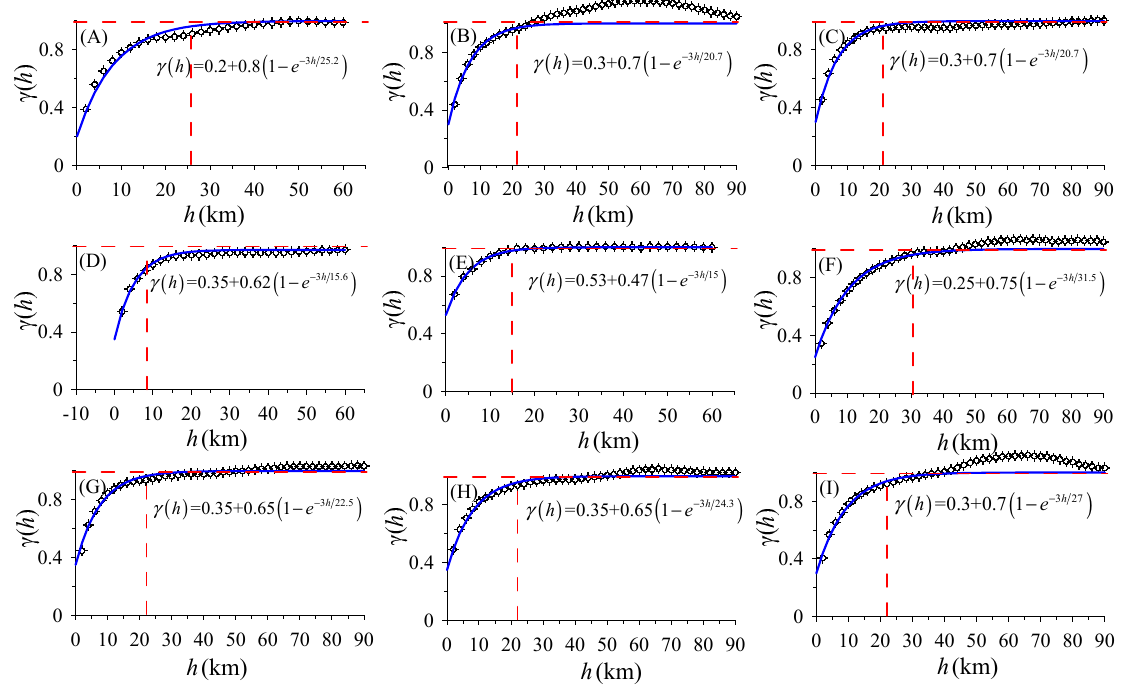
Figure 5. Semivariograms of 9 selected geochemical elements. ( A ) Cu, ( B ) Pb, ( C ) Zn, ( D ) Ag, ( E ) Au, ( F ) Sb, ( G ) W, ( H ) Sn, ( I ) Mo. Note that normal score transformation was performed before semivariogram calculation and modeling. Also shown on the plot are the locations of range, sill and the fitted exponential variogram model.